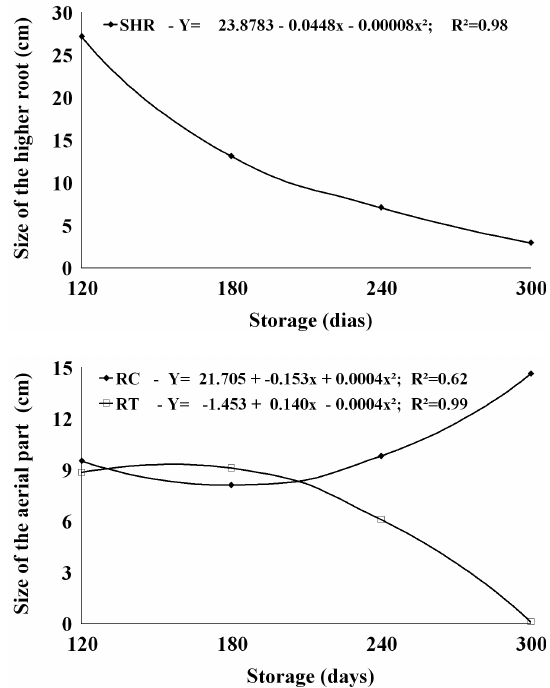
Fig. 6- Size of the higher root (a) and size of the aerial part (b) of Croton urucurana seedlings from the seeds stored at room temperature and under refrigeration condition and incubated in under greenhouse